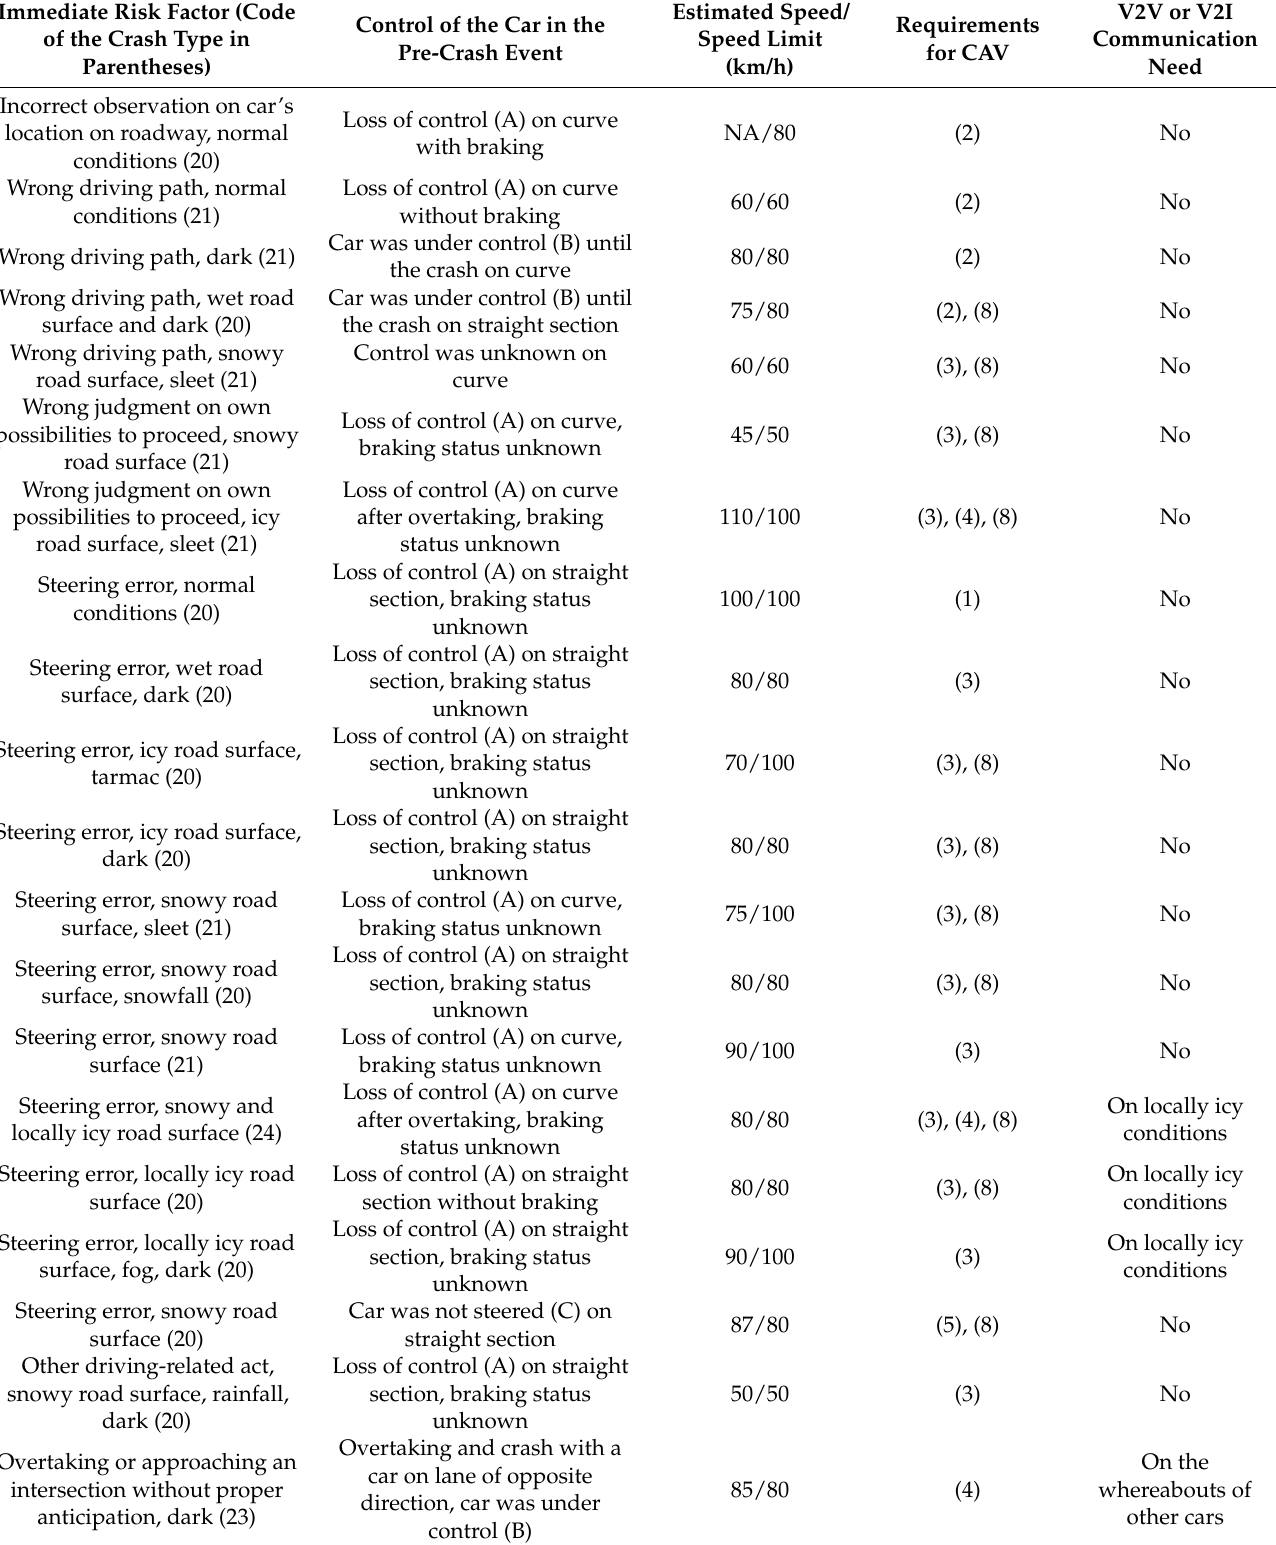
Table 1. Characteristics of the 20 studied head-on